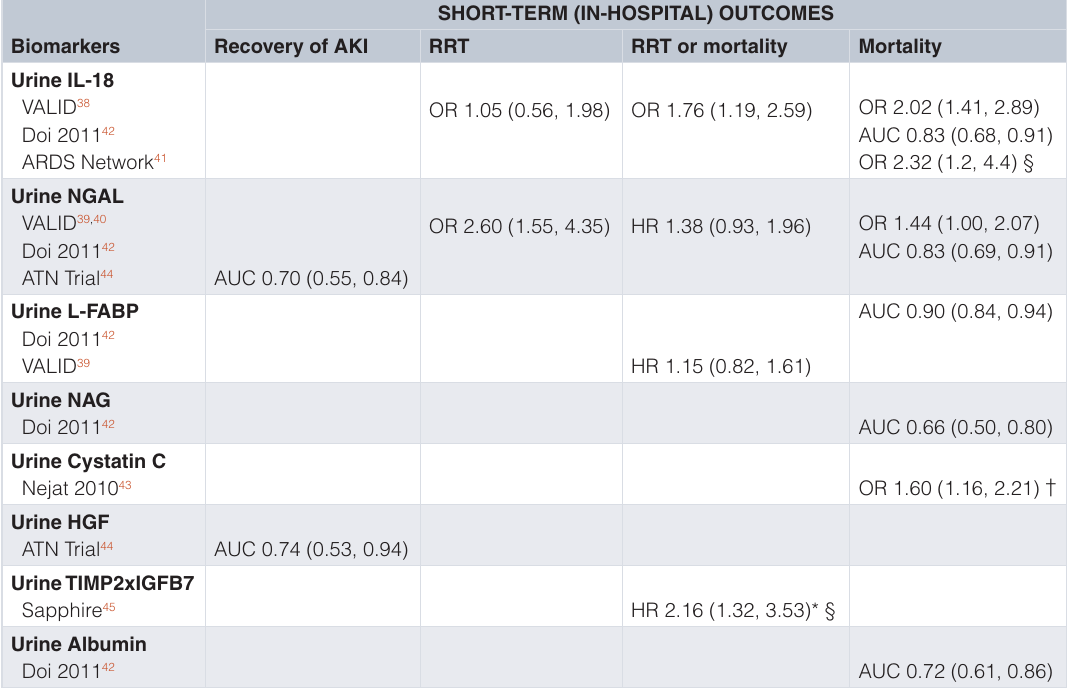
Table 2. Biomarkers of AKI and outcomes in critically ill patients.